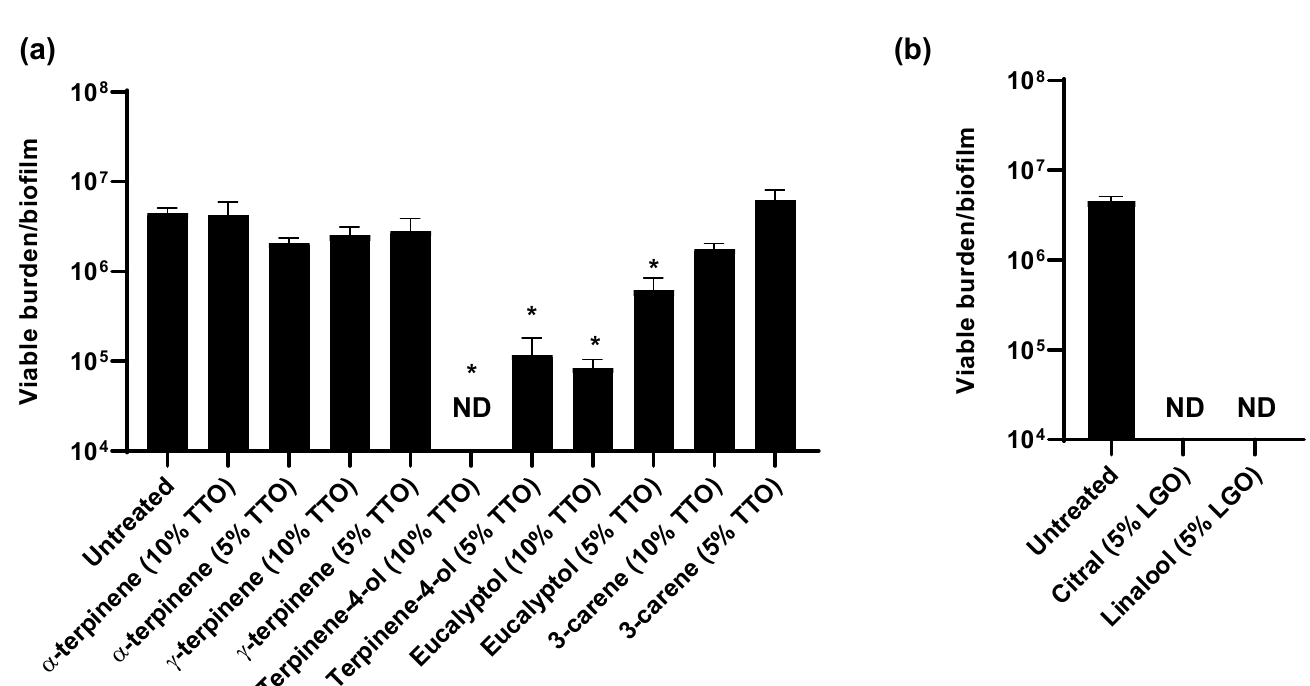
Figure 4. Impact of essential oil components on C. auris in vitro: ( a , b ) C. auris biofilms were propagated in synthetic sweat media in 12-well plates for 24 h. Essential oil components were applied for 1 h and the remaining viable burden was determined by plating. Component concentrations were selected based on the concentrations present in 5 or 10% TTO ( a ) or 5% LGO. Data were analyzed by one-way ANOVA with Holm–Sidak multiple comparison on the control, * p < 0.05, ND = not detectable, standard error of the mean shown, n = 3.